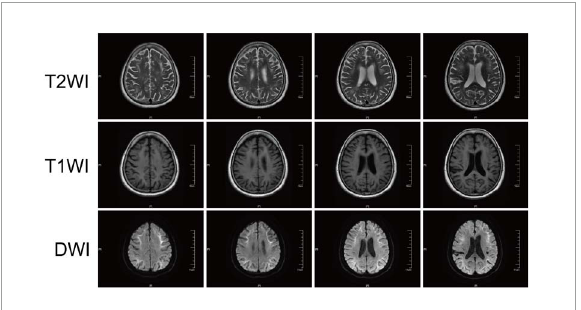
FIGURE2 The typical brain magnetic resonance imaging (MRI) in patients with NIID. Curved or ribbon-like high signals along the corticomedullary junction, a strong clue for NIID, are found in the DWI sequence of head MRI of some patients with NIID.